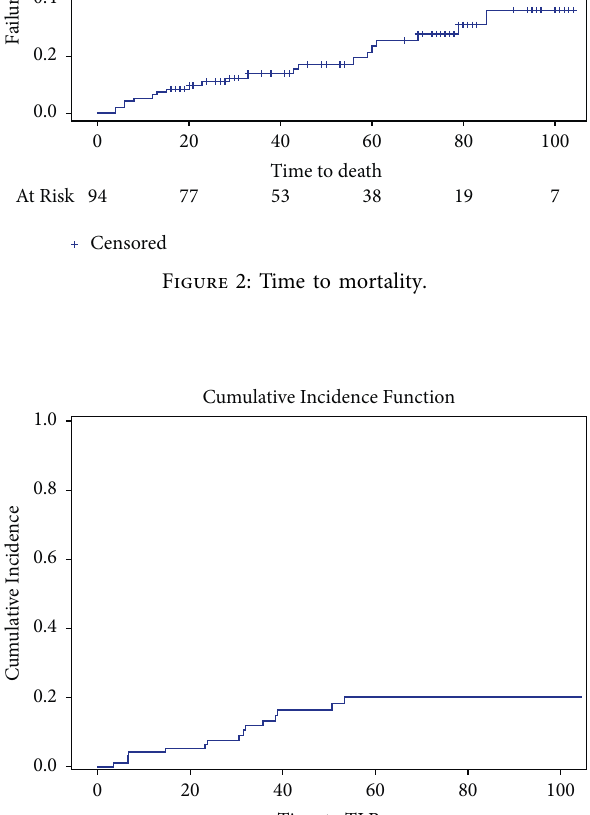
Figure 1: Time to MACE.